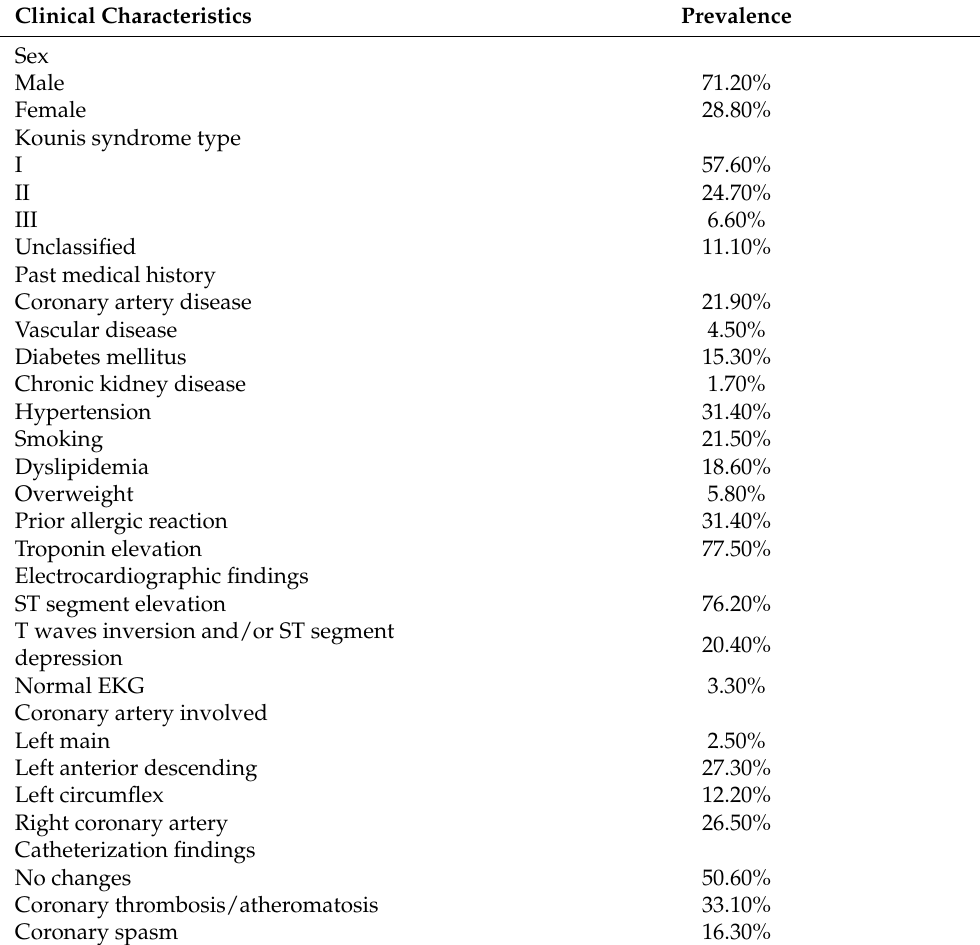
Table 2. Baseline clinical characteristics of patient presenting with Kounis